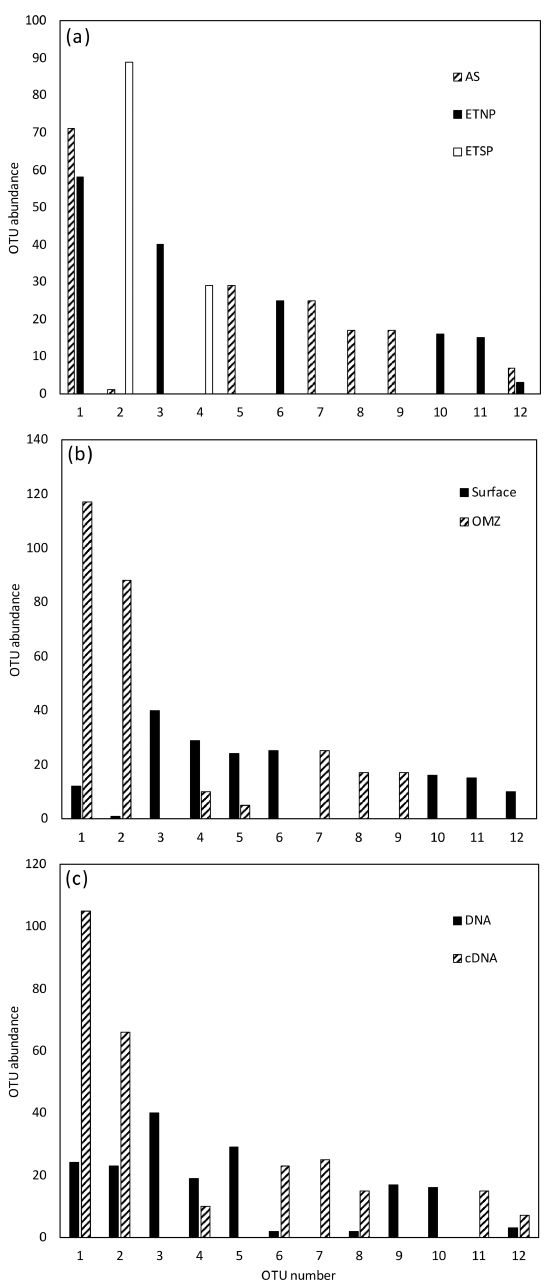
Figure 1. Histogram of the 12 most common OTUs from the Clus- ter I nifH clone libraries from the three OMZ regions. OTUs were considered common if the total number of sequences in an OTU was ≥ 2% of the total number of nifH clones analyzed (the com- mon OTUs contained 441 of the 512 Cluster I sequences). OTUs were defined according to 3% nucleotide sequence difference us- ing the furthest-neighbor method. OTU designation is from most common (OTU-1) to least common. (a) OTU distribution among regions. (b) OTU distribution between OMZ (including the core of the ODZ and the upper oxycline depths) and surface depths (oxy- genated water). (c) OTU distribution of cDNA vs. DNA clones.